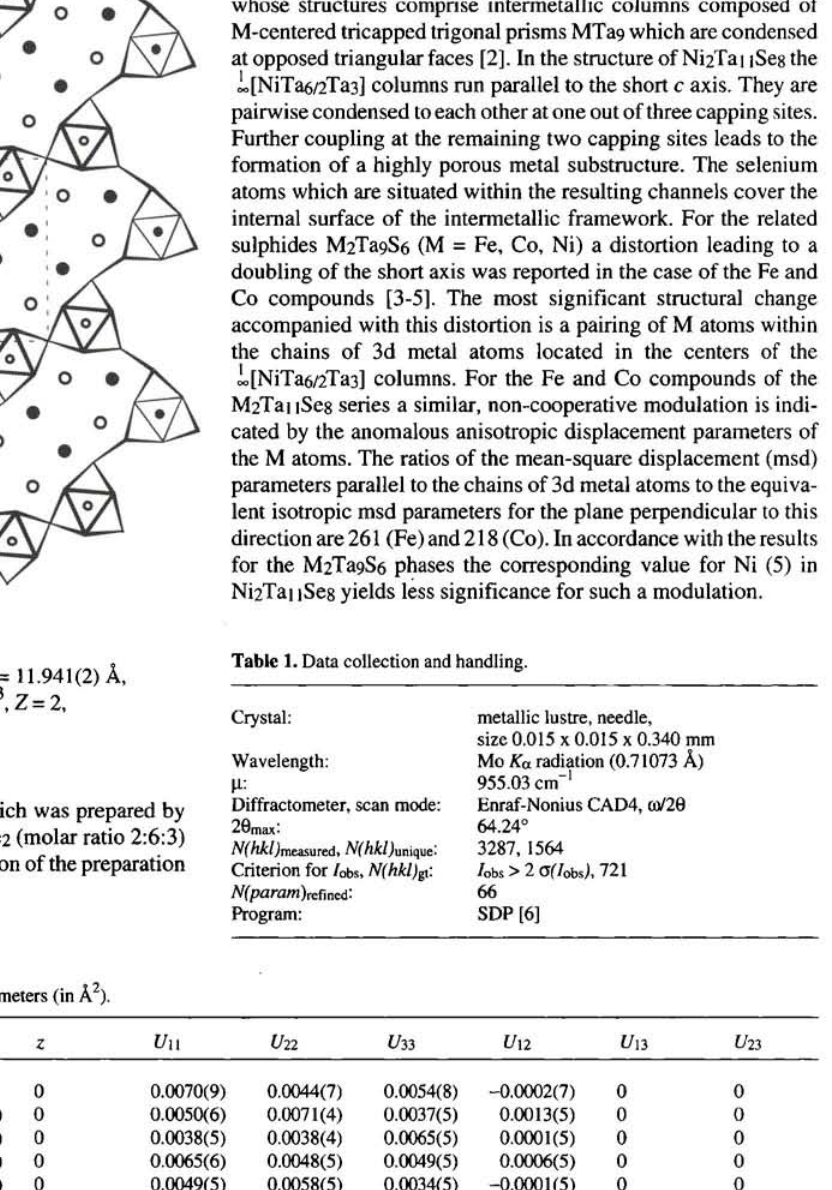
Table 2. Atomic coordinates and displacement parameters (in Â 2